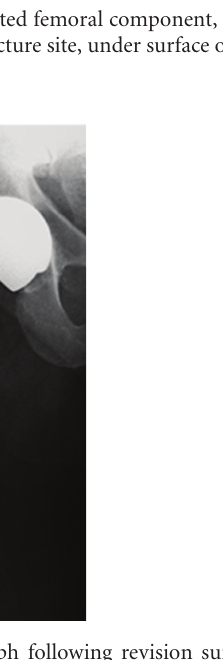
Figure 3: Anteroposterior radiograph following revision surgery using C-stem